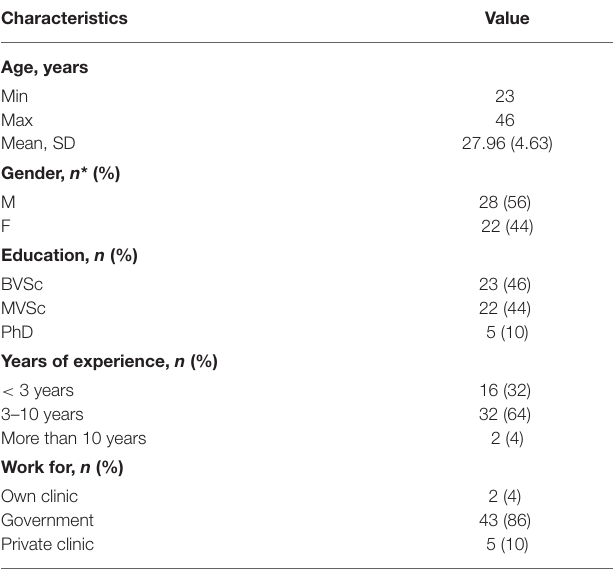
TABLE 1 | Characteristics of veterinarians who participated in the survey. Characteristics